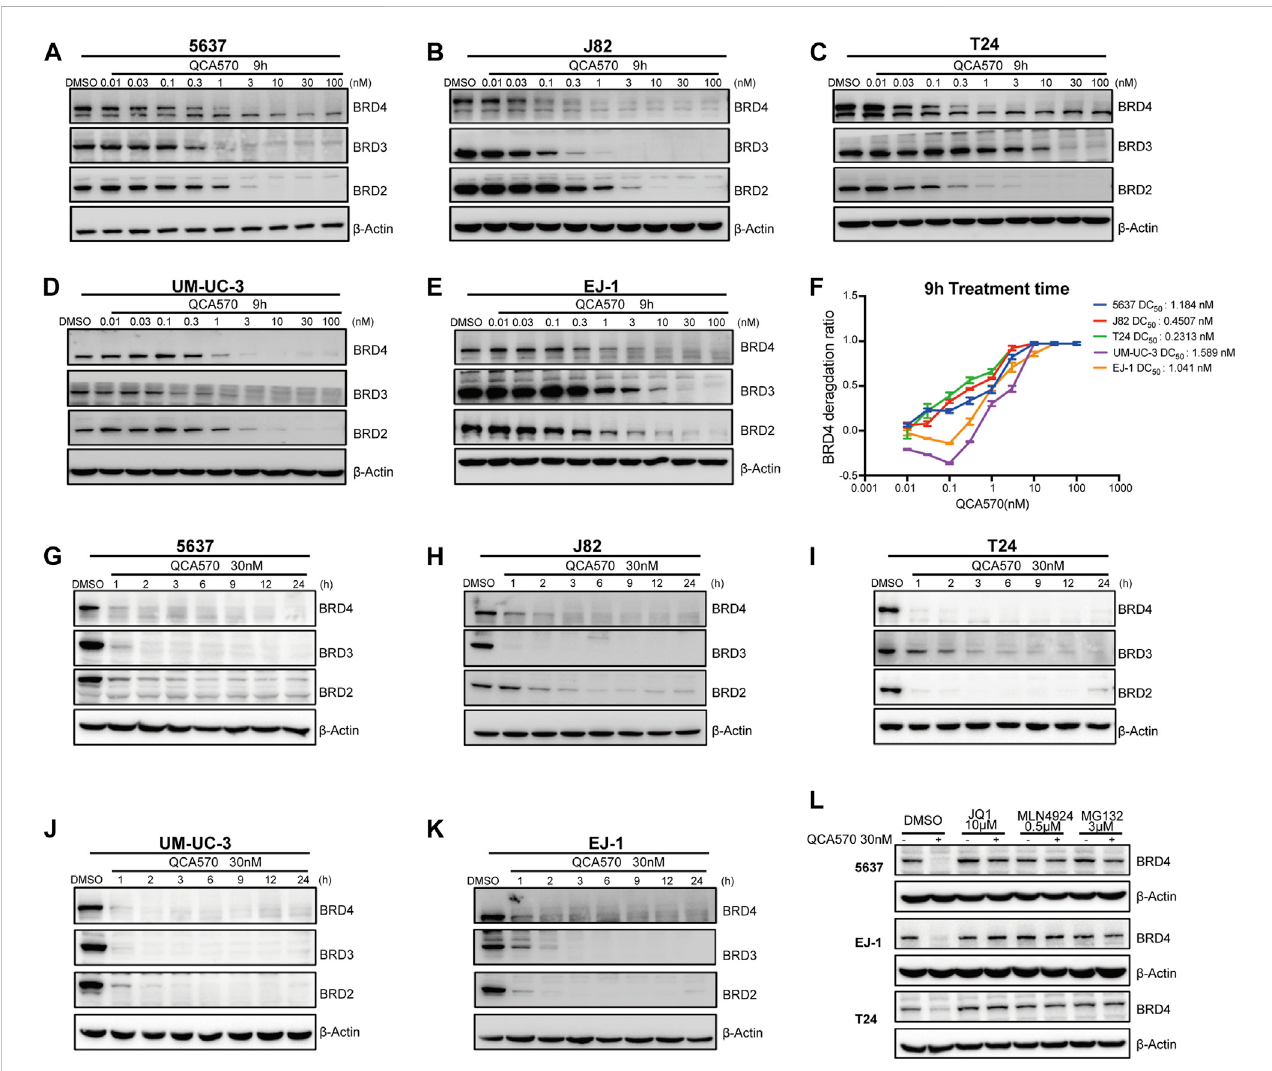
curve was plotted with GraphPad Prism 9. (G – K) BC cells were treated with 30 nM of QCA570 for indicated time points. BET family protein levels were determined by Western blotting and GAPDH was used as loading control. (L) Cells were pretreated with BETi JQ1, neddylation activating E1